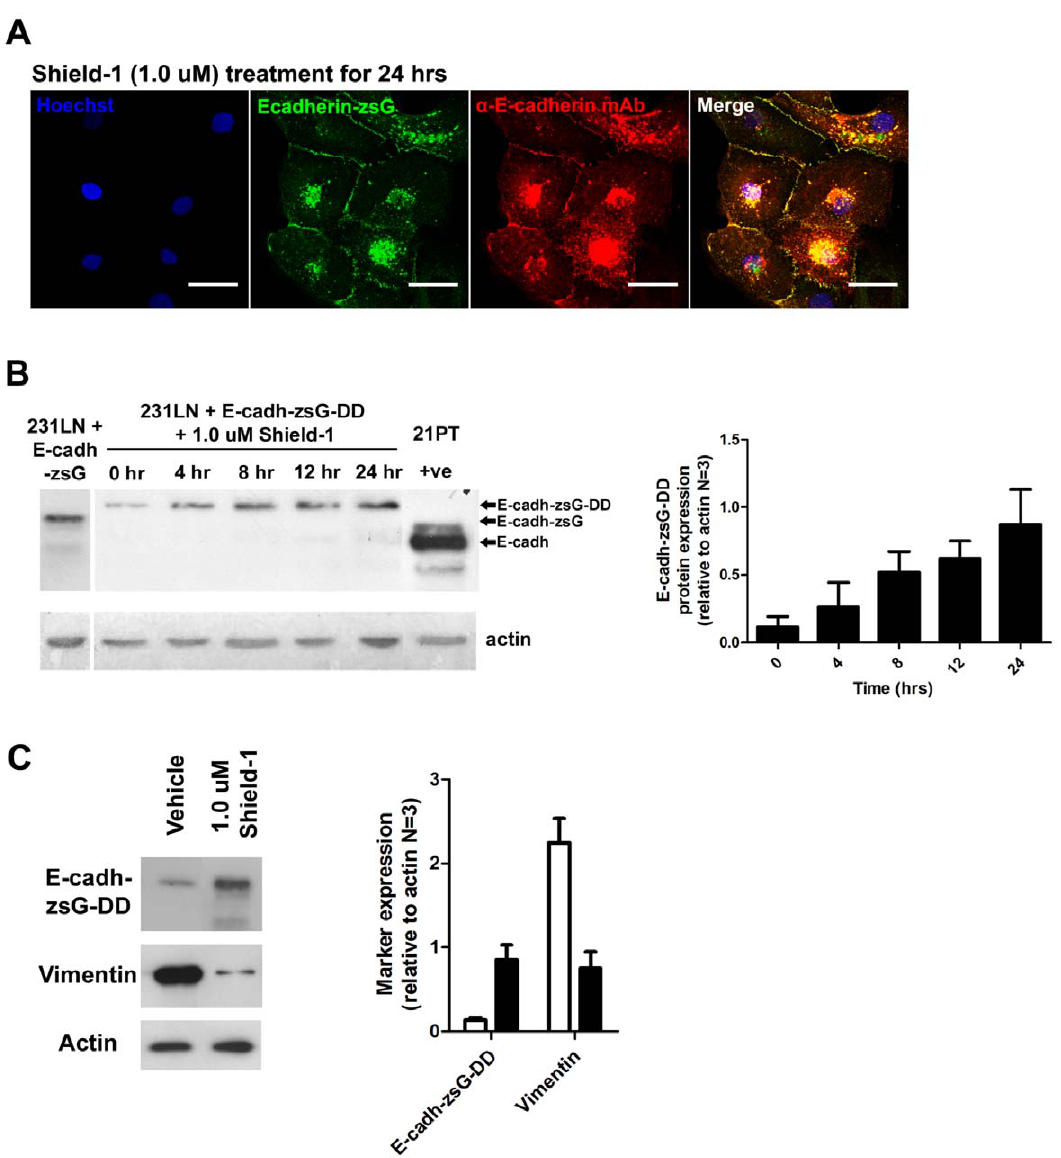
Figure 4. Induction of E-cadherin-zsG-DD protein in 231LN cells by Shield-1 ligand and expression of vimentin. A) 231LN cells expressing E-cadh-zsG-DD (green) treated with 1.0 m M Shield-1 for 24 hours and immunostained with anti-E-cadherin mAb (red) and Hoechst nuclear stain (blue). Scale bars are 25 m m. B) Western immunoblot analysis of E-cadherin expression in 231LN cells expressing E-cadh-zsG-DD and treated with 1.0 m M Shield-1 using the same mAb as in A). Graph (right) represents analyses performed on three independent induction experiments. Cell lysates of 231LN cells expressing E-cadherin-zsG are shown in the first lane. Lysates of cells expressing E-cadherin-zsG-DD were collected at 0, 4, 8, 12, 16, and 24 hrs after Shield-1 treatment (1.0 m M final), revealing accumulation of Shield-1 stabilized E-cadherin-zsG-DD within cells ( , 135 kDa). Far right lane is a positive control of 21PT cells [32] which endogenously express high levels of E-cadherin ( , 110 kDa). C) Western immunoblot analysis of markers for epithelial-mesenchymal transition (EMT). Blot (left panels) reveals a decrease in vimentin protein levels when E-cadh-zsG-DD is induced by 1.0 m M Shield-1 treatment. Graph (right) represents analyses performed on three independent induction experiments.